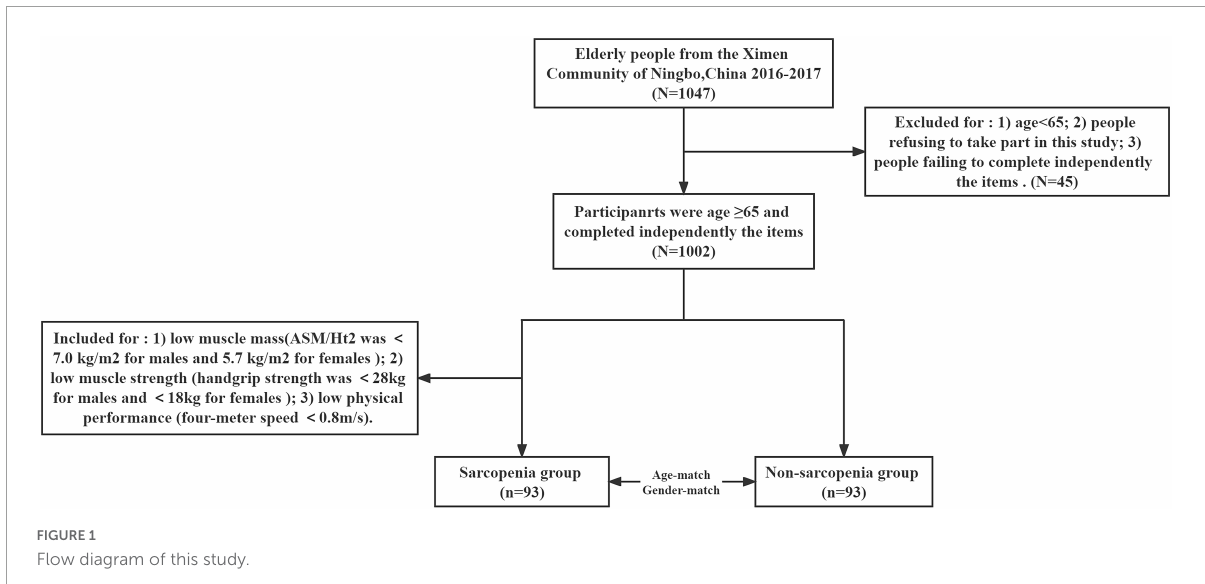
FIGURE1 Flow diagram of this